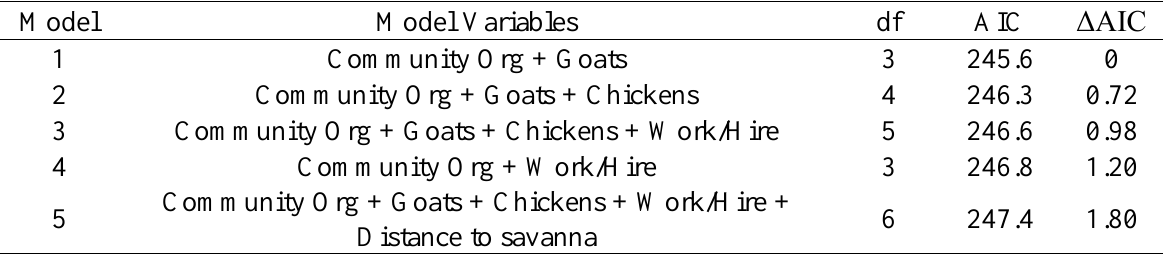
Table A2.6 Akaike information Criteria (AIC), change in AIC (ΔAIC) and degrees of freedom (df) from the top competing regression models of whether a household had any successful adaptations as a function of individual metrics of household